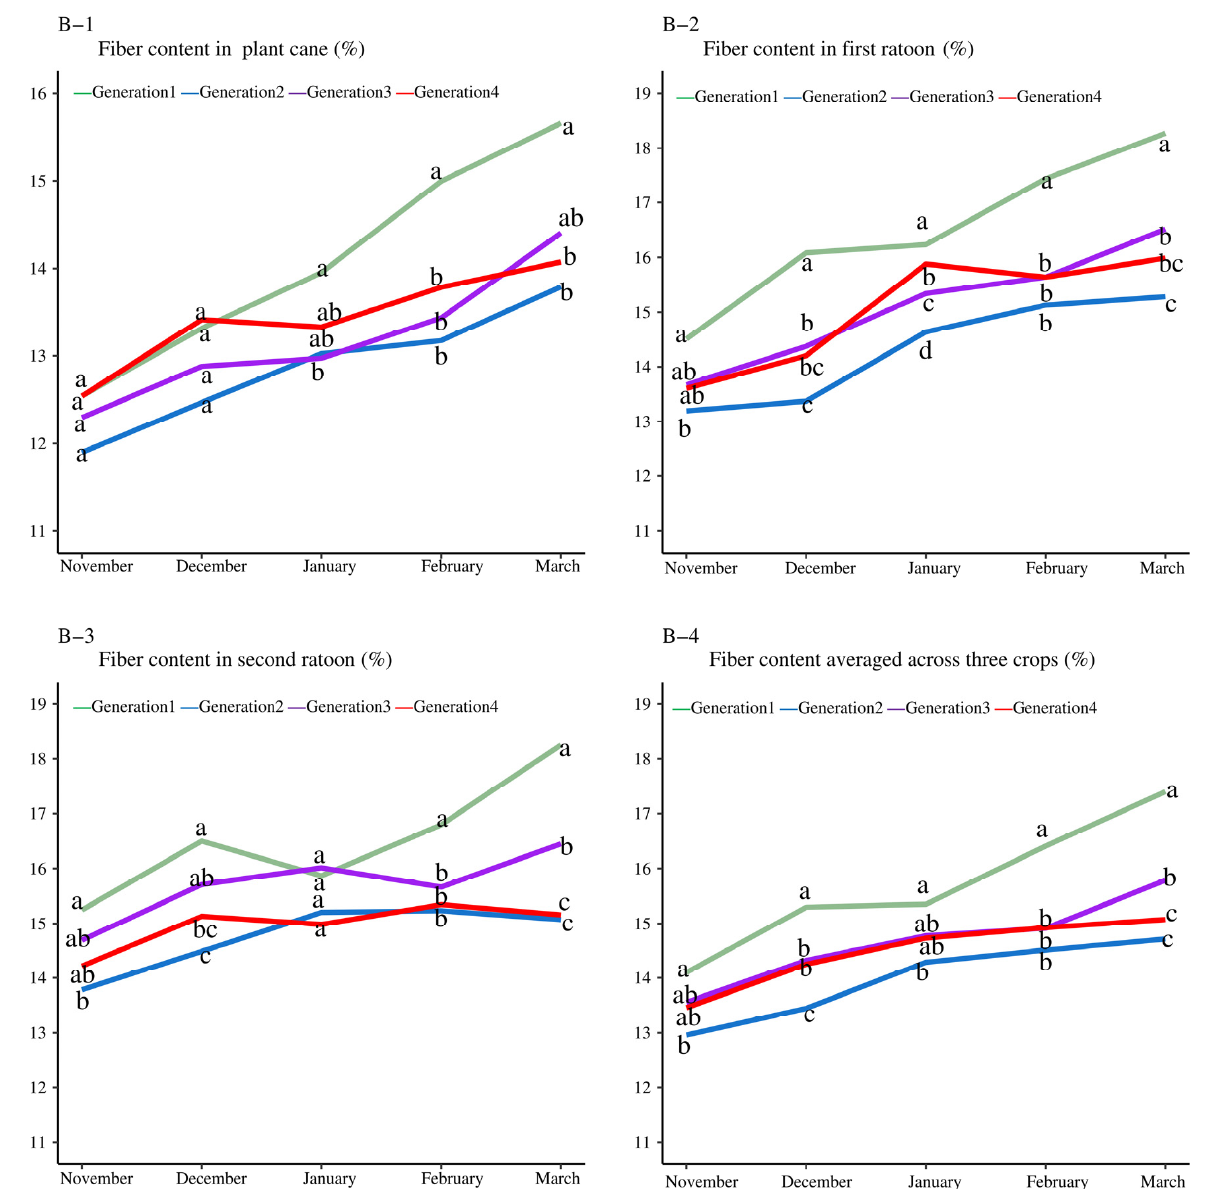
Figure 2. Analysis of the improvement in fiber content in four generations of sugarcane varieties in China. Monthly differences (November to March) of the four generations for planted cane ( B-1 ), the first ratoon ( B-2 ), the second ratoon ( B-3 ), and the average content across three crops( B-4 ). a, b, c, d, p < 0.05, determined by the LSD test; the LSD test was across generations within a month.